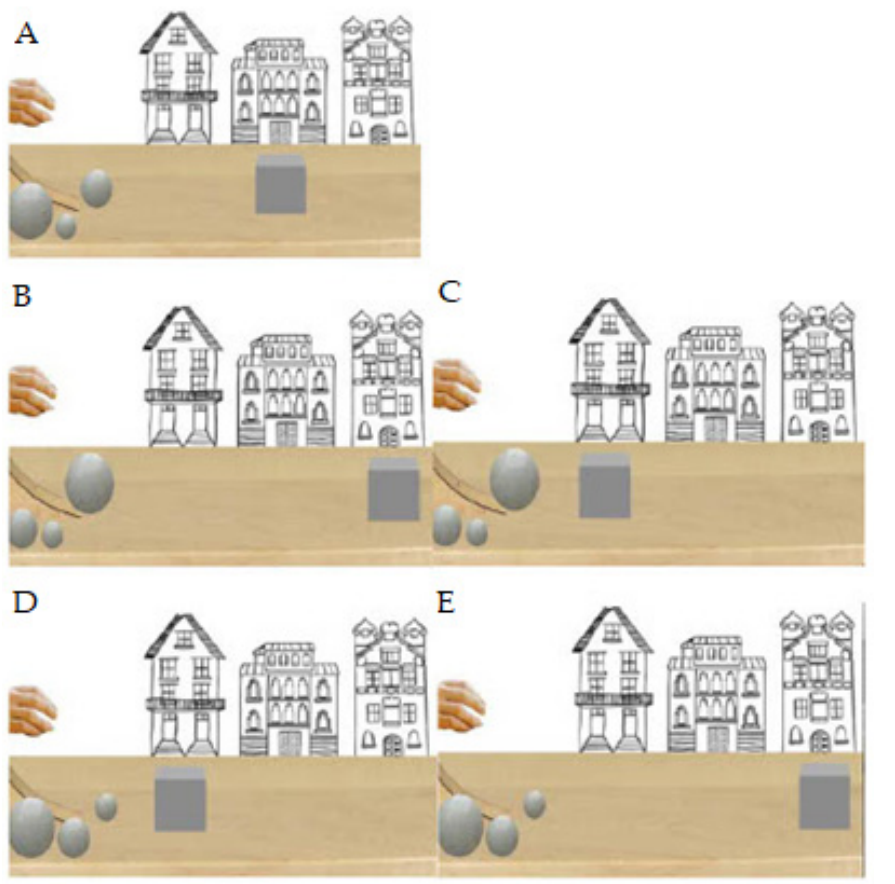
Figure 2. ( A ) Habituation event, ( B ) Large ball congruent, ( C ) Large ball incongruent, Bottom: ( D ) Small ball congruent, ( E ) Small ball incongruent event outcomes.